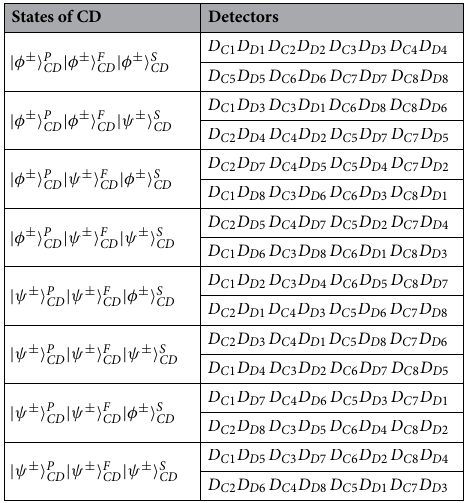
Table 2. The relation between the states of photon pair CD and the measurement results.